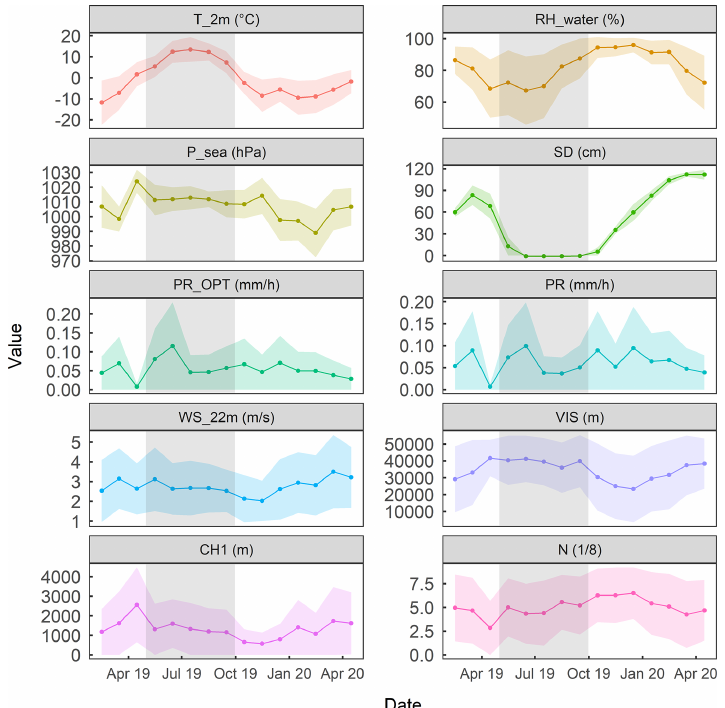
Figure A1. Time series of monthly weather parameters (means: dots and connecting lines, and standard deviations: ribbons) at the mea- surement site in Sodankylä from February 2019 to April 2020. The following variables are shown (from the upper left to the bottom right): ambient air temperature at 2m aboveground ( T 2m in ◦ C), relative humidity with respect to water (RH water in %), pressure at sea level ( P sea in hPa), snow depth (SD in cm), precipitation rate measured optically (PR OPT in mmh − 1 ) and by weight (PR mmh − 1 ), wind speed (WS at 22m aboveground in ms − 1 ), horizontal visibility (VIS in m), height of the lowest cloud base (CH1 in m), and total cloudiness (N, a value between 1 and 8). The grey areas mark the months, from May to September, that were excluded from our analysis.